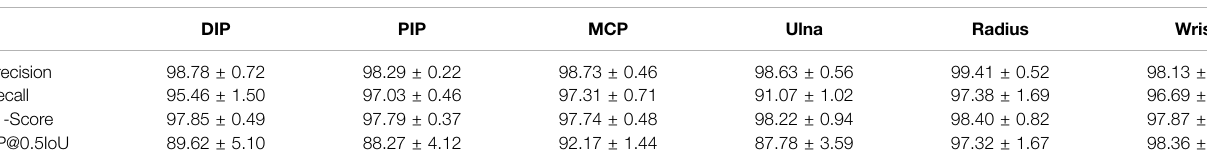
TABLE 1 | Evaluation of ROIs detection by using Faster R-CNN.